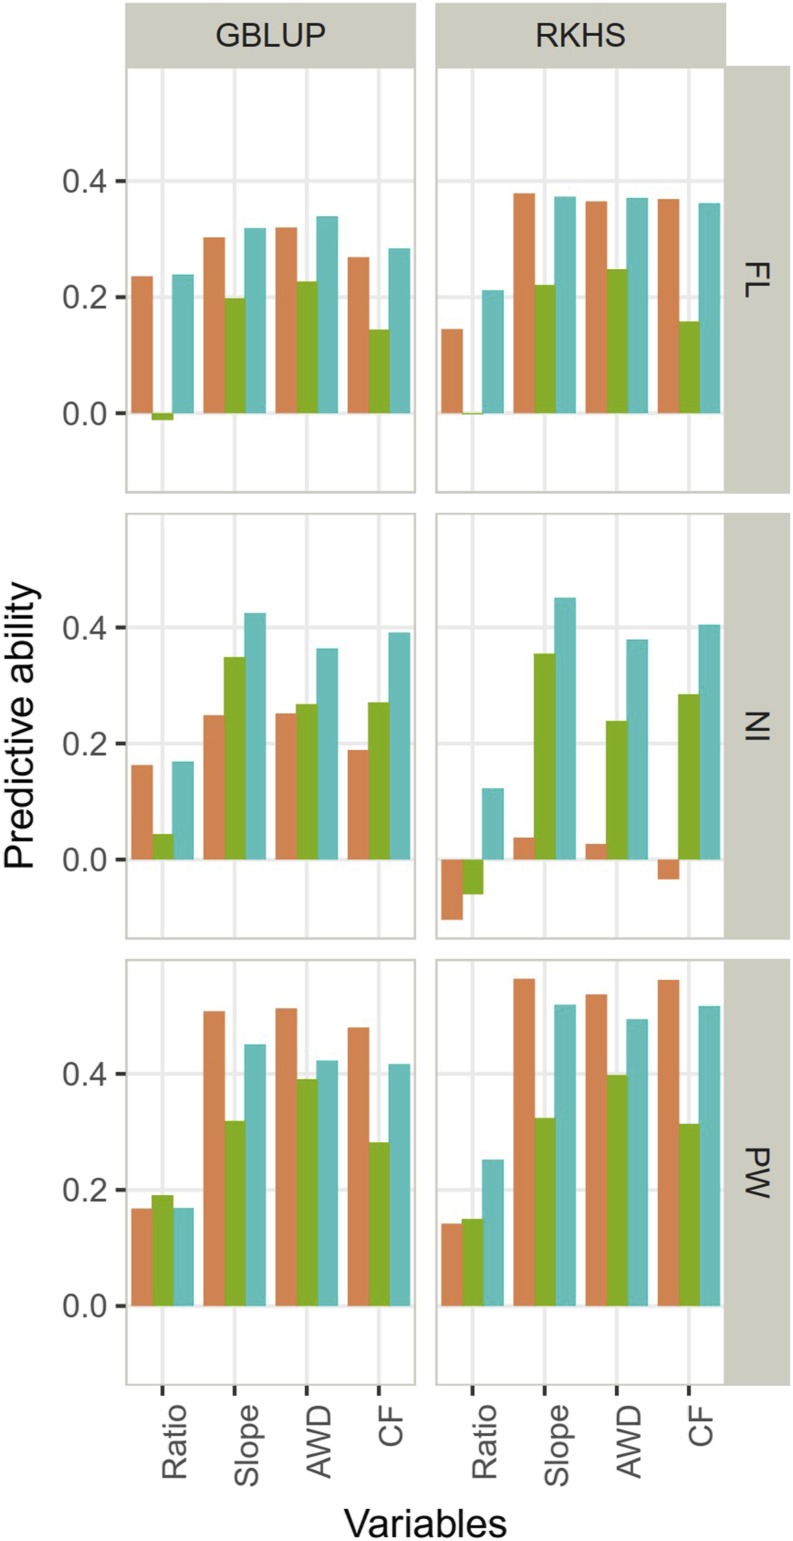
Predictive ability of genomic prediction in across population validation for the response variables (index and slope) and the performance within each condition (continuous flooding – CF and alternate wetting and drying – AWD) obtained. Two statistical models (GBLUP, RKHS) and three traits (days to flowering (FL), nitrogen balance index (NI) and 100 panicle weight (PW)) were studied. The scenarios used to define the training set are in color: orange (S1: only the parents), green (S2: 100 individuals of the RP selected with CDmean) and blue (S3: the whole RP).